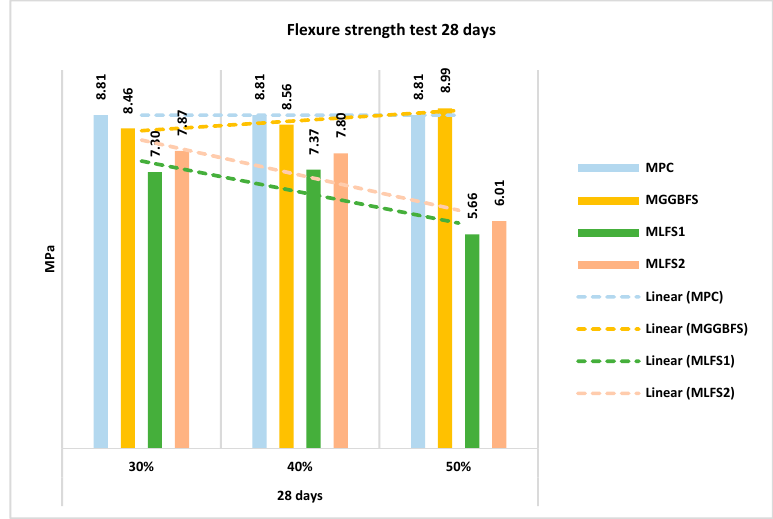
Figure 10. Flexure strength test 28 Days. Materials 2019 , 12 , x FOR PEER REVIEW